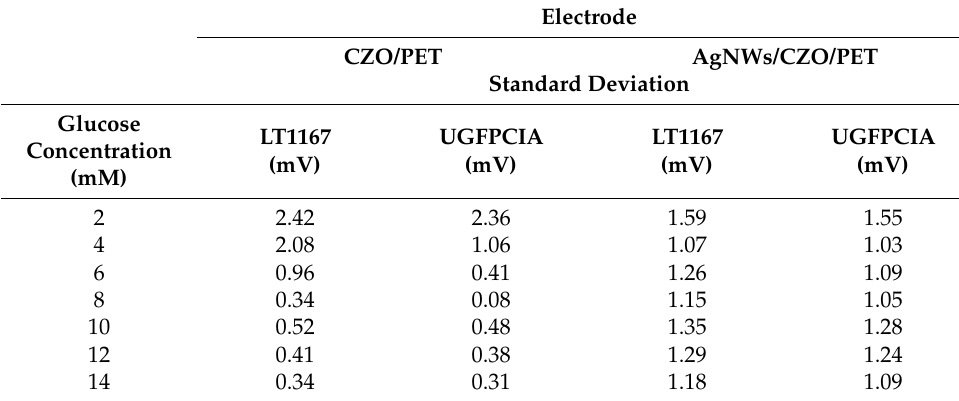
Table 1. The standard deviations of the different glucose